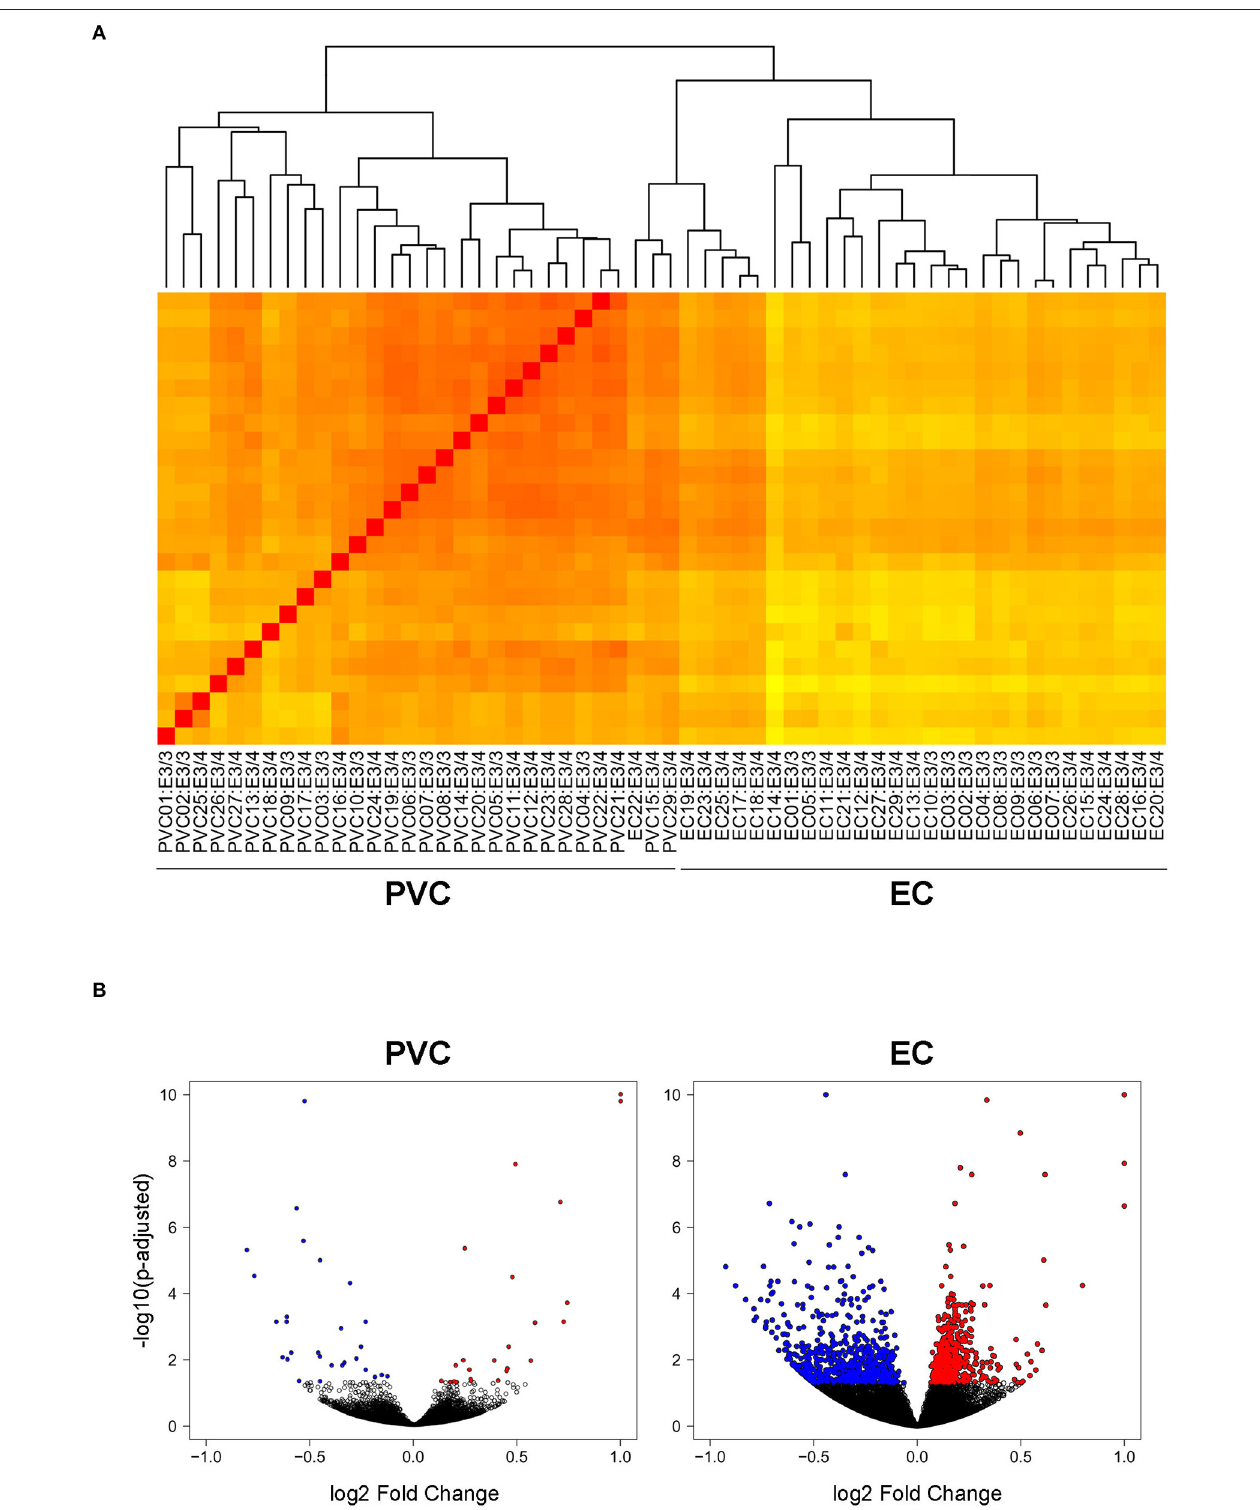
FIGURE 1 | Transcriptomics analysis was performed on RNA extracted from the EC and PVC of aged APOE3/4 vs. APOE3/3 mice. RNA-sequencing was performed to analyze the effects of differential APOE isoform expression on RNA levels in the PVC and EC of aged APOE mice APOE3/4 (19 APOE3/4 males vs. 10 APOE3/3 males). (A) A heat map visualizing the Euclidean distance between samples, with darker red colors indicating increased similarity. (B) Volcano plots visualizing the fold change and adjusted p -values of each gene that was differentially expressed in the PVC and EC of APOE3/4 vs. APOE3/3 mice.